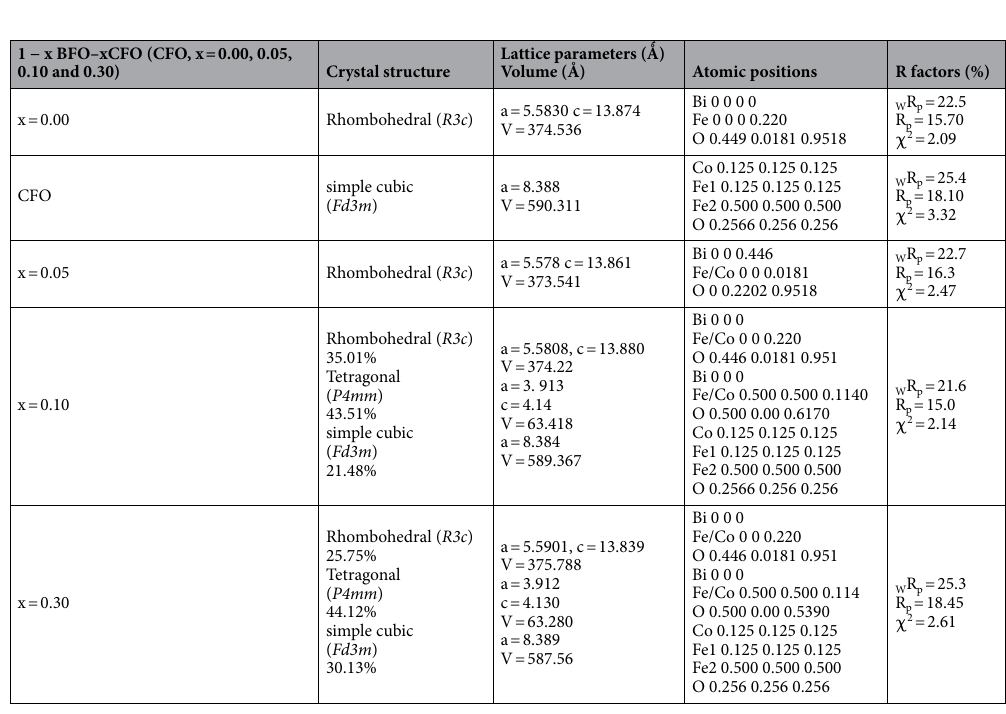
Table 1. Relevant parameters obtained from Rietveld refinement of XRD pattern for [(1 − x) BFO–x CFO (CFO, x = 0.00, 0.05, 0.10 and 0.30)] samples.